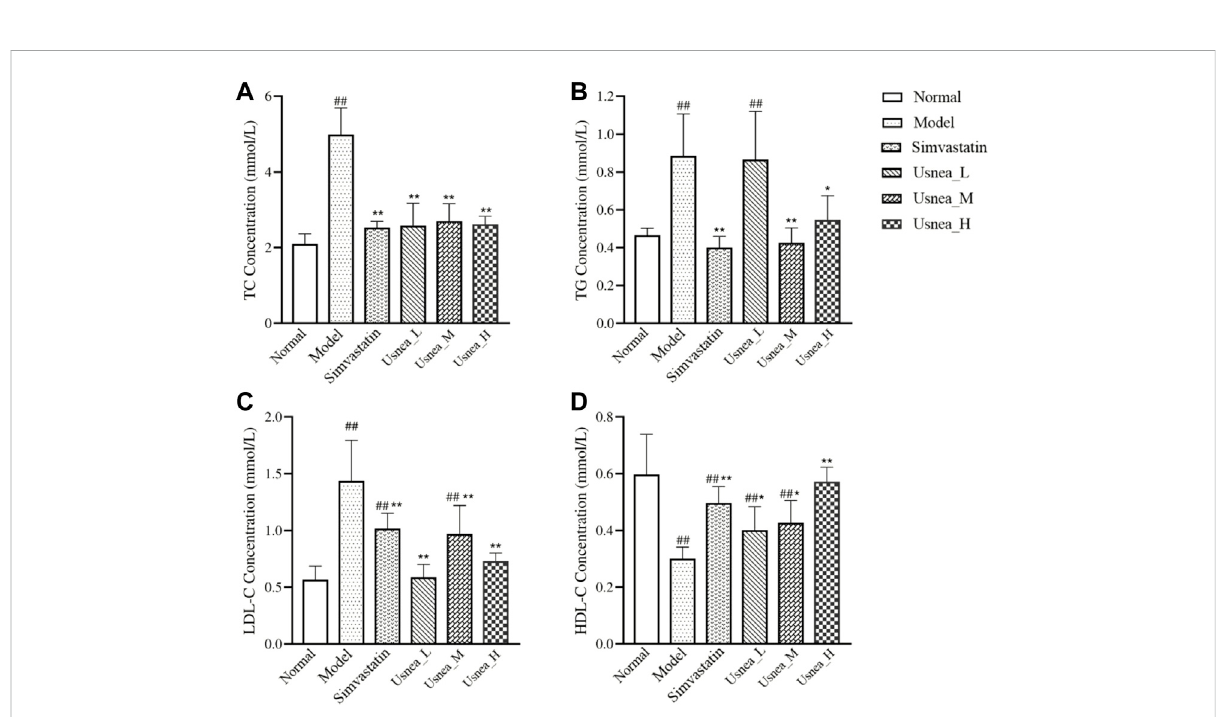
FIGURE 5 Effects of UEE on serum lipid levels in rats. (A) Effect of UEE on TC concentration; (B) effect of UEE on TG concentration; (C) effect of UEE on LDL-C concentration; (D) effect of UEE on HDL-C concentration. Results are expressed as the mean ± SD ( n = 6 per group). Compared with the normal group, # p < 0.05, ## p < 0.01; compared with the model group * p < 0.05, ** p <